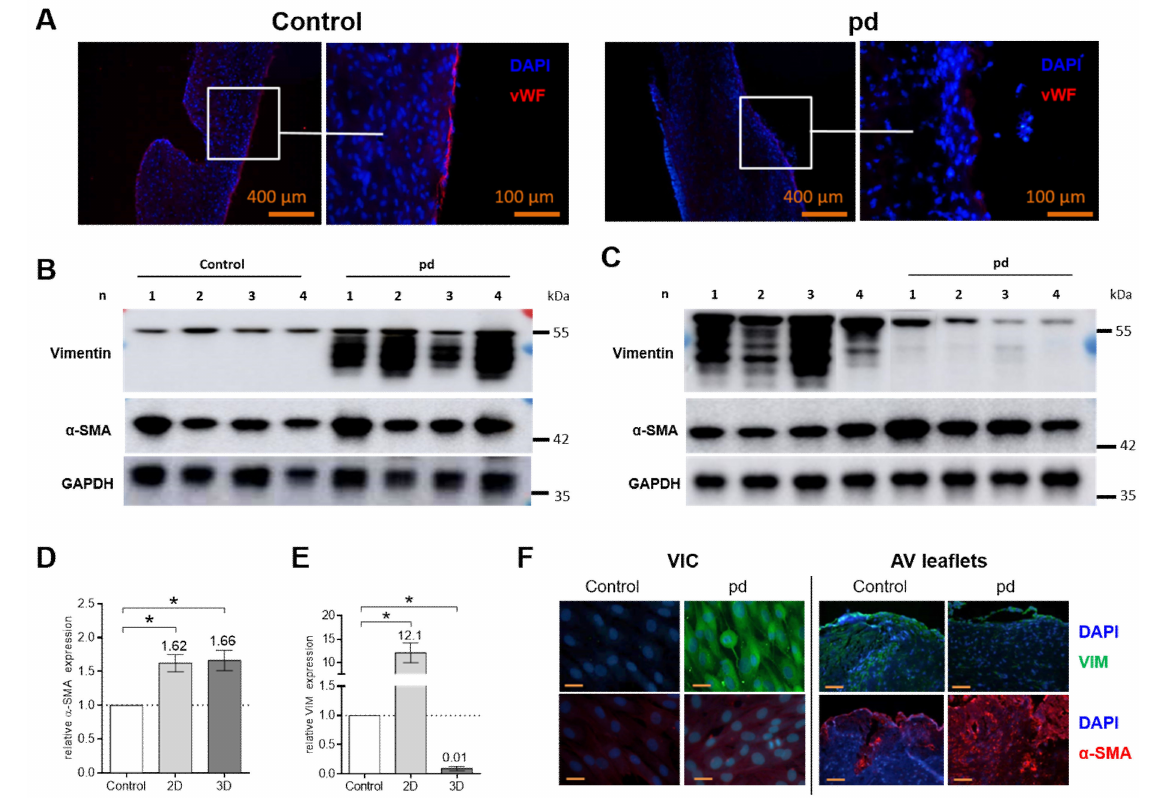
Figure 4. Analysis of endothelial layer and expression of VIM and α -SMA. ( A ) Immunohistological images with antibodies against von Willebrand factor (vWF) of AV leaflets under pro-degenerative (pd, β -GP + CaCl 2 ) and control conditions after a 28 d cultivation period. Representative images of four different experiments are shown. Scale bar indicates 400 or 100 µ m. Western blot images of 2D VIC cultures after 7 d ( B ) and AV leaflets after 28 d ( C ) for vimentin (VIM), smooth muscle alpha actin ( α -SMA) and glyceraldehyde 3-phosphate dehydrogenase (GAPDH) under pd and control conditions. Density analysis for quantification of α -SMA ( D ) and VIM ( E ) in 2D VIC cultures and AV leaflets. Data ( n = 4) are mean ± SEM. p -values are calculated by using Kruskal–Wallis test with Dunn’s multiple comparison post hoc test. *: p < 0.05. Data were normalized to GAPDH and expressed relative to control conditions. ( F ) Immunohistological images with antibodies against VIM (green) and α -SMA (red) of 2D VIC cultures and AV leaflets under pd and control conditions. Representative images of four different experiments are shown. DAPI, 4 (cid:48) ,6-diamidino-2-phenylindole; VIC, Valvular interstitial